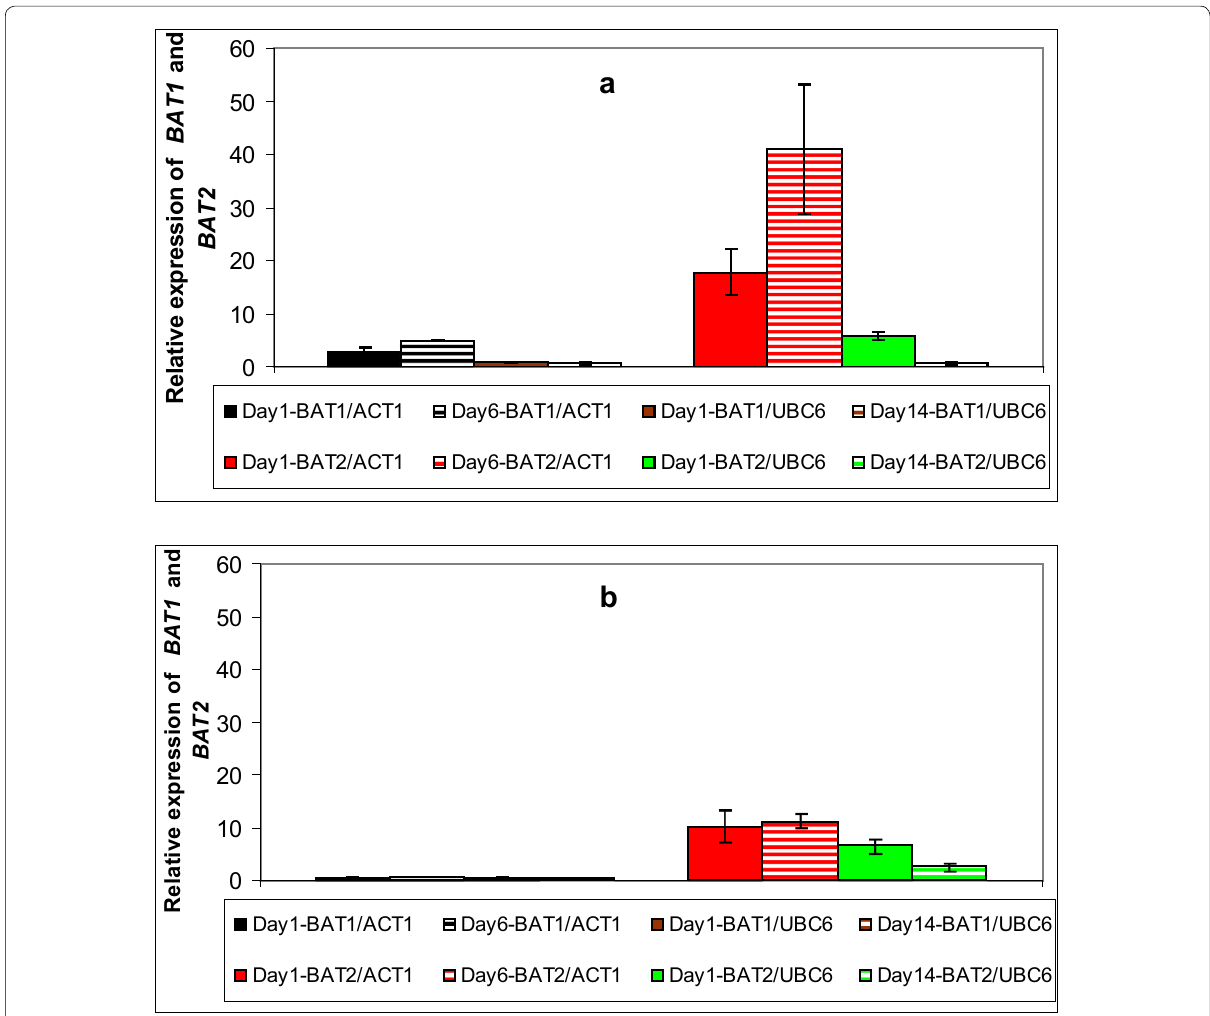
Fig. 2 Expression of genes BAT1 and BAT2 during Debina must fermentations. a Strain VL1 and b strain Z622. In a and b : gene expression on day 1 was normalized against the expression levels of both ACT1 and UBC6 genes, whereas: (i) on day 6 expression values were normalized against ACT1 and (ii) on day 14 against UBC6. In each set of values, the first bar corresponds to day 1 normalized against ACT1 , second bar to day 6 normalized against ACT1, third bar to day 1 normalized against UBC6 and fourth bar to day 14 normalized against